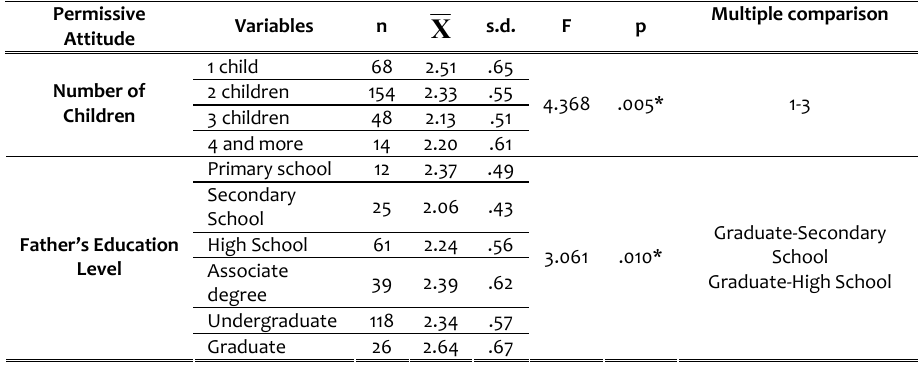
Table 8. Results of ANOVA test related to the permissive attitude subscale and number of children and father’s education level Permissive Attitude